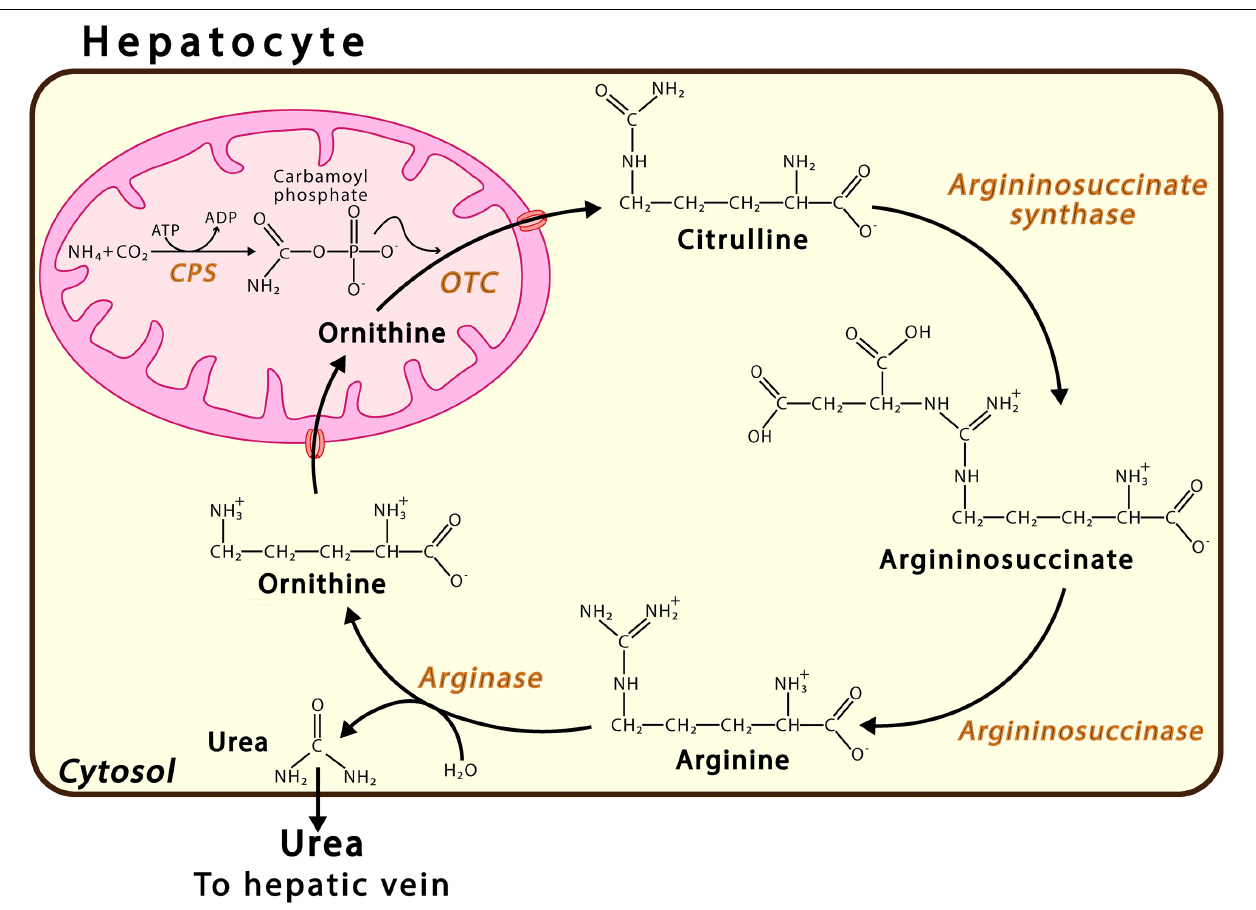
FIGURE 1 | Urea Cycle. This pathway takes place in the periportal hepatocytes. Urea synthesis proceeds via a sequence of six enzymatic reactions, the first three located in the mitochondrion and the last three in the cytosol. The continuity of this process also requires transport proteins in the mitochondrial membrane, such